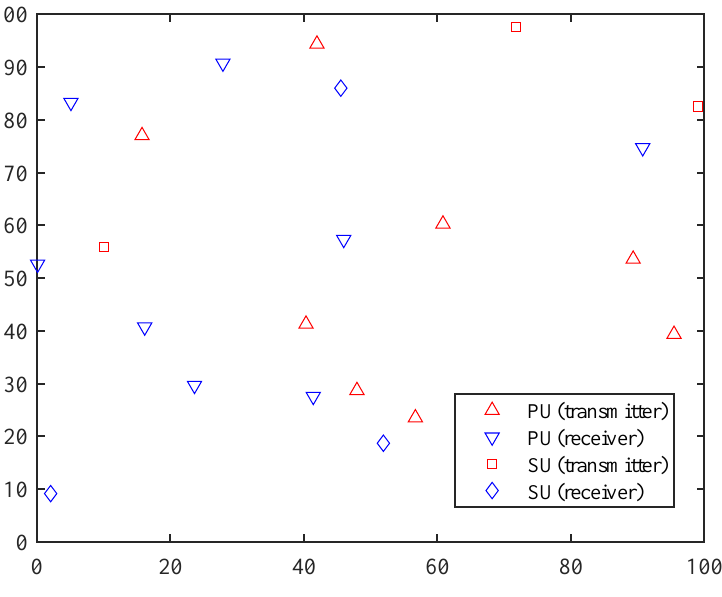
Figure 1. Positions of SUs and